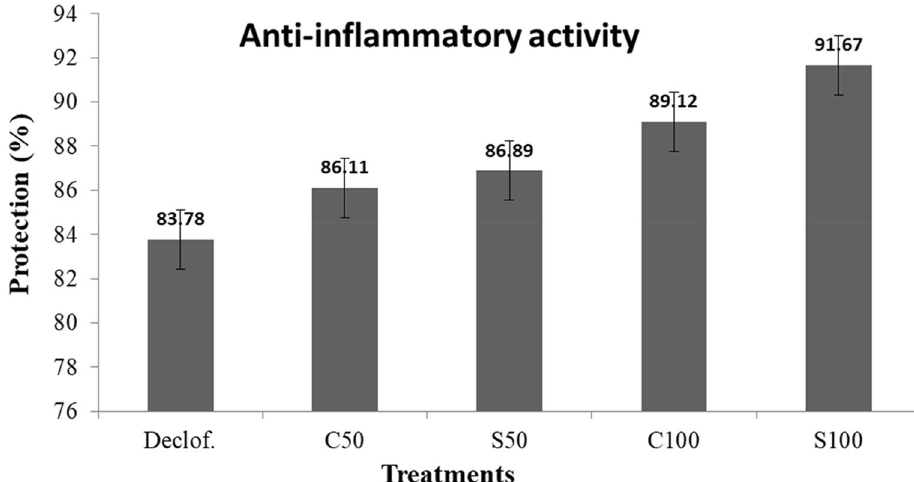
Fig. 3 The effect of fermentation by S. cerevisiae on anti‑inflammatory properties of C. cassia extract: Declof.—non‑steroidal anti‑inflammatory and phenylacetic acid derivative drug (standard at concentration of 2000 μg/mL); C50—non‑fermented cinnamon at 50 ppm; S50—fermented cinnamon at 50 ppm; C100—non‑fermented cinnamon at 100 ppm; and S100—fermented cinnamon at 100 ppm